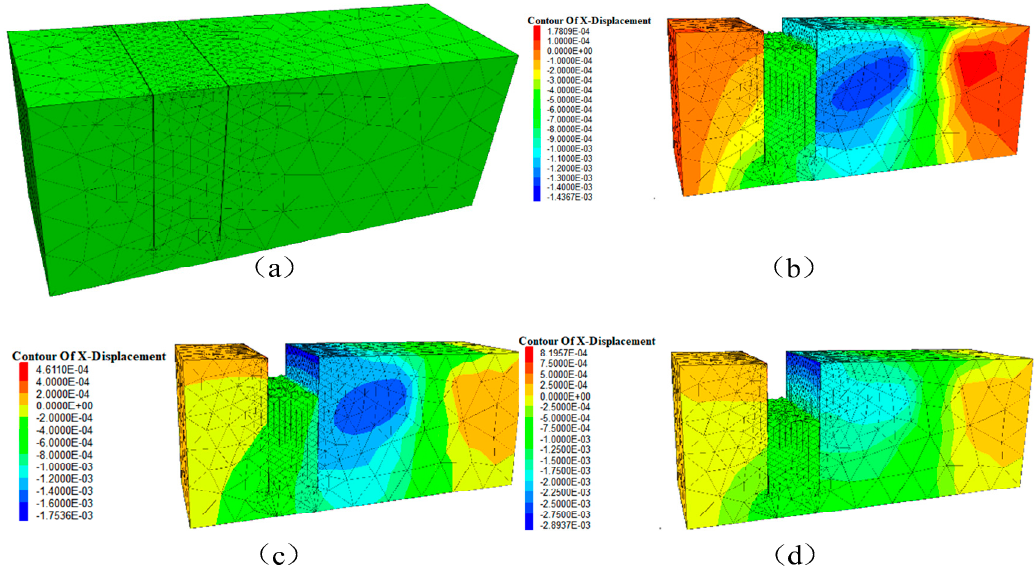
Figure 12. The displacement analysis of the test model. ( a ) finite element model, ( b ) displacement nephograms of the test model with an excavation depth of 15 cm, ( c ) displacement nephograms of the test model with an excavation depth of 30 cm, ( d ) displacement nephograms of the test model with an excavation depth of 45 cm.